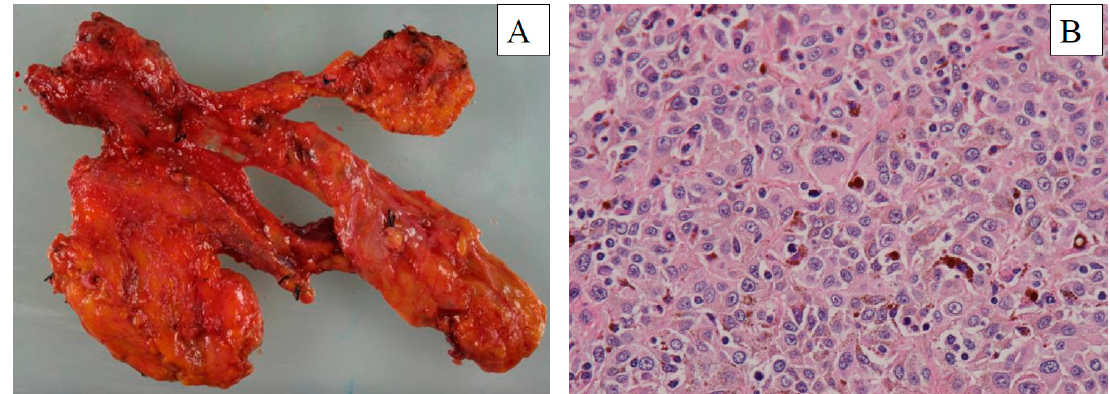
Figure 4. ( A ) Surgical specimen and ( B ) hematoxylin and eosin stained tissue following salvage neck dissection of the metastatic malignant melanoma. Scale bar = 100 µm . Arrows showed brown melanin. Please define the different color area in ( B ).